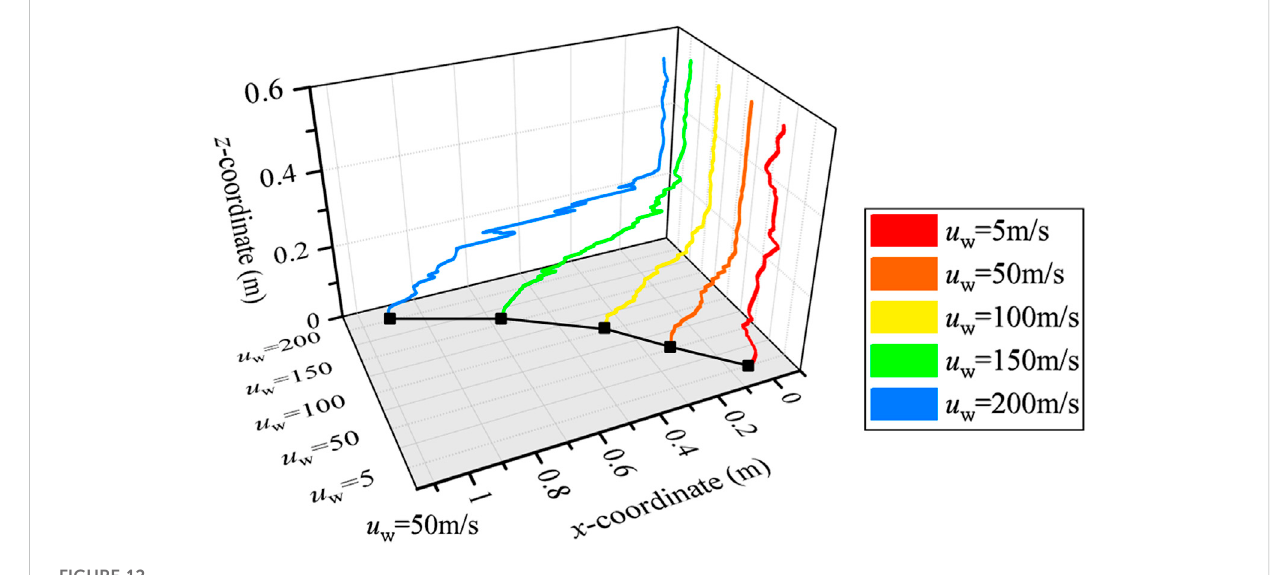
FIGURE 12 Comparison of the sweeping arc at the aerodynamic fl ow 5 – 200 m/s.